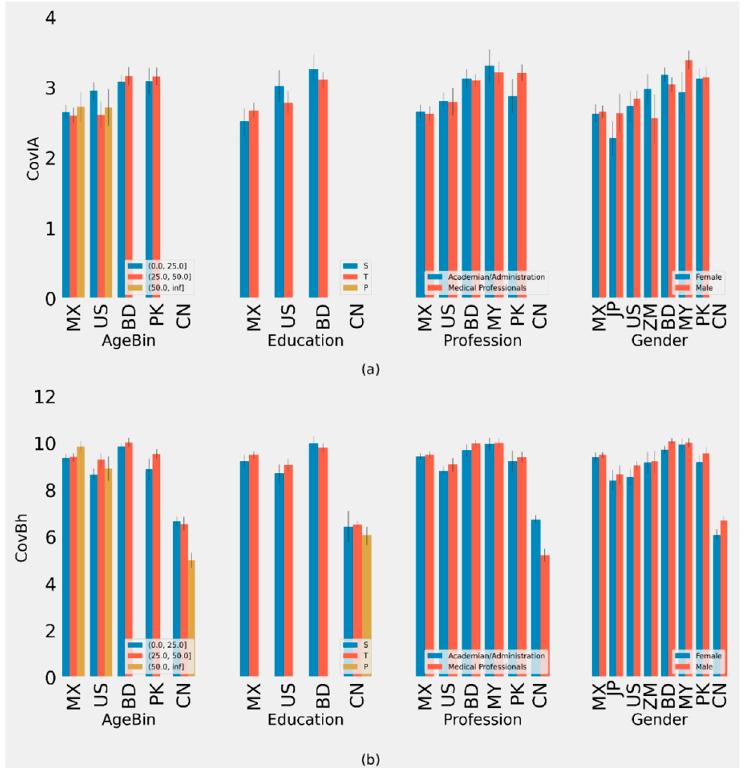
Figure 1. ( a ) Plot of Average CovKd metric of different groups with 90% CI. ( b ) Plot of Average CovPsy metric of different groups with 90% CI. (ISO-2 Codes for countries are used.)